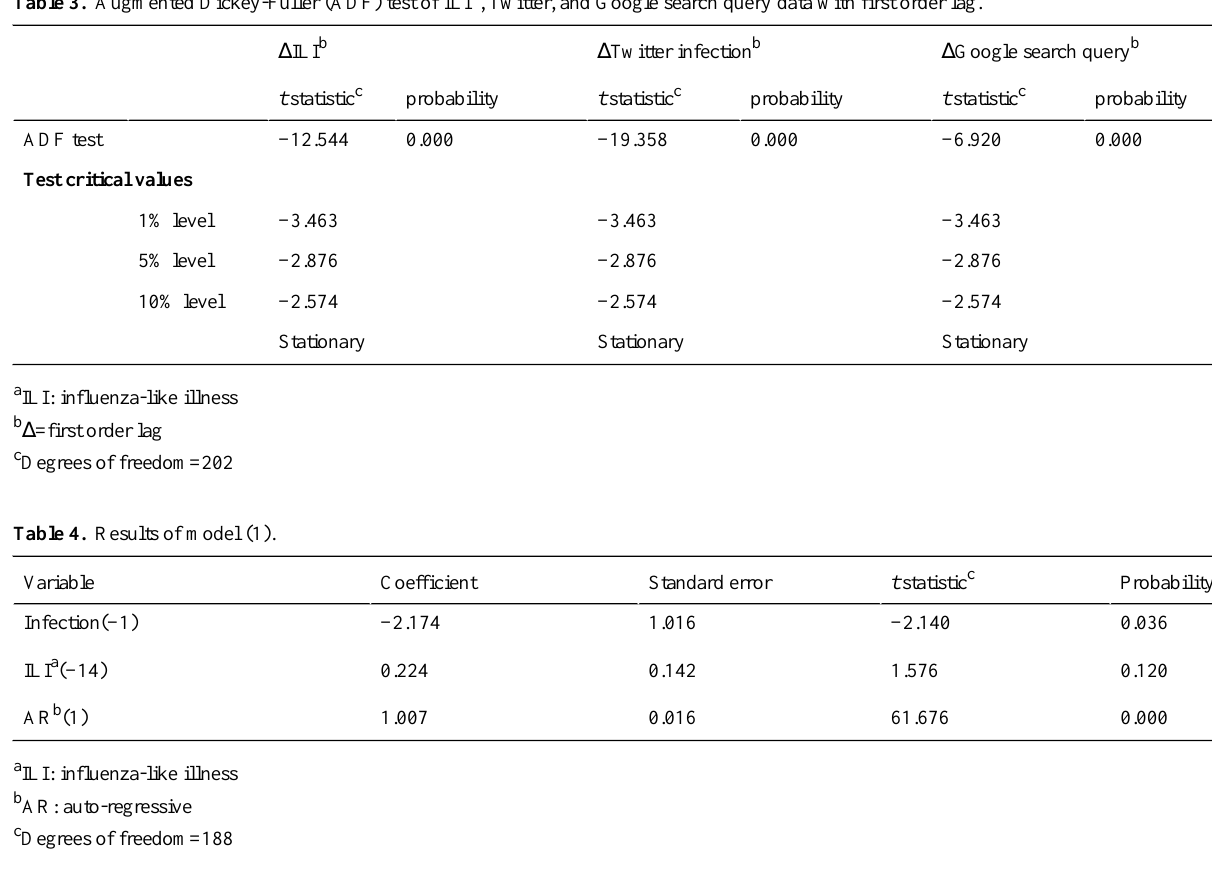
Table 3. Augmented Dickey-Fuller (ADF) test of ILI a , Twitter, and Google search query data with first order lag.